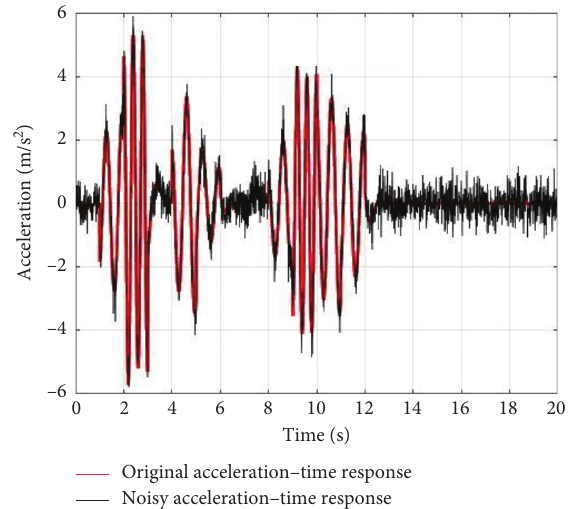
Figure 5: Noisy acceleration-time